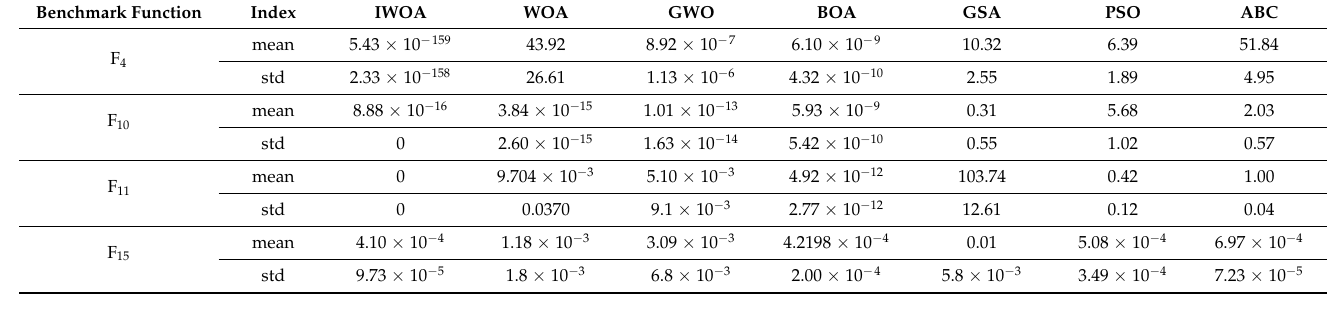
Table 2. Comparison of the results for IWOA and other optimization algorithms.